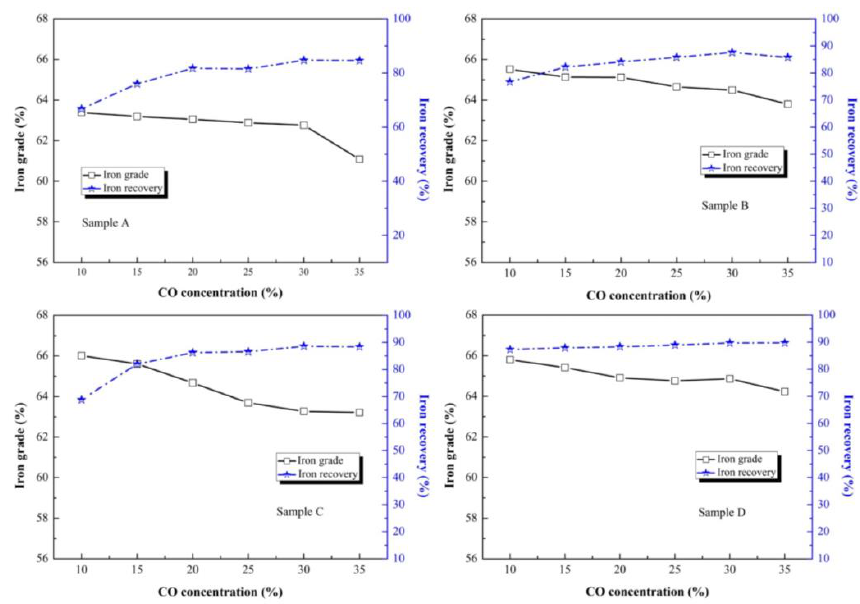
Figure 10. The iron grade and iron recovery of sample A to D with different CO ratios.